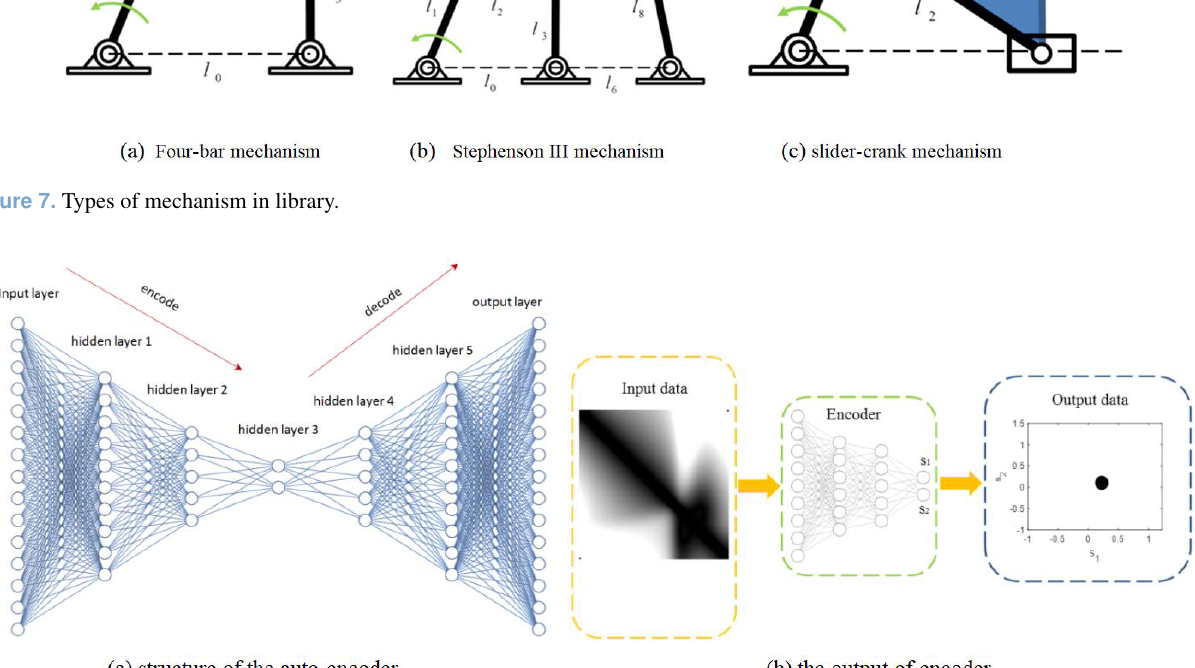
Figure 8. The auto-encoder and its innermost layer outputs.